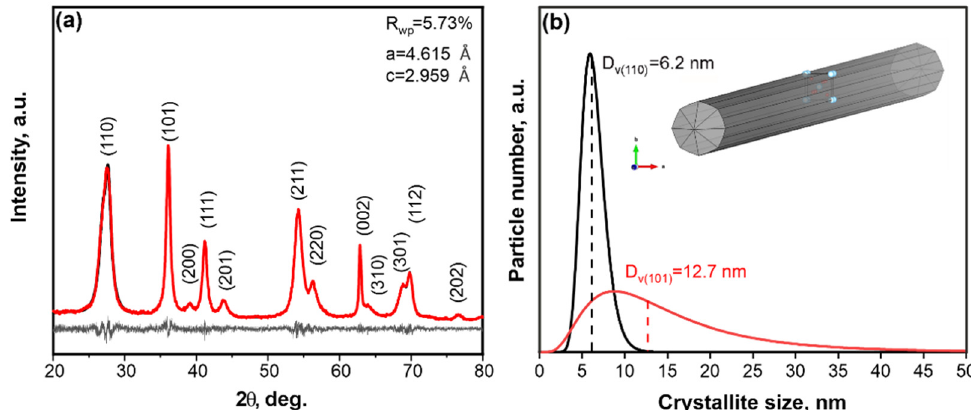
Figure 5. ( a ) Results of the X-ray data refinement in P4 2 /mnm for the r -TiO 2 sample. ( b ) Calculated crystallite size distributions for crystallite domains along (110), and (101) crystallographic directions, insert: reconstructed crystallite morphology.